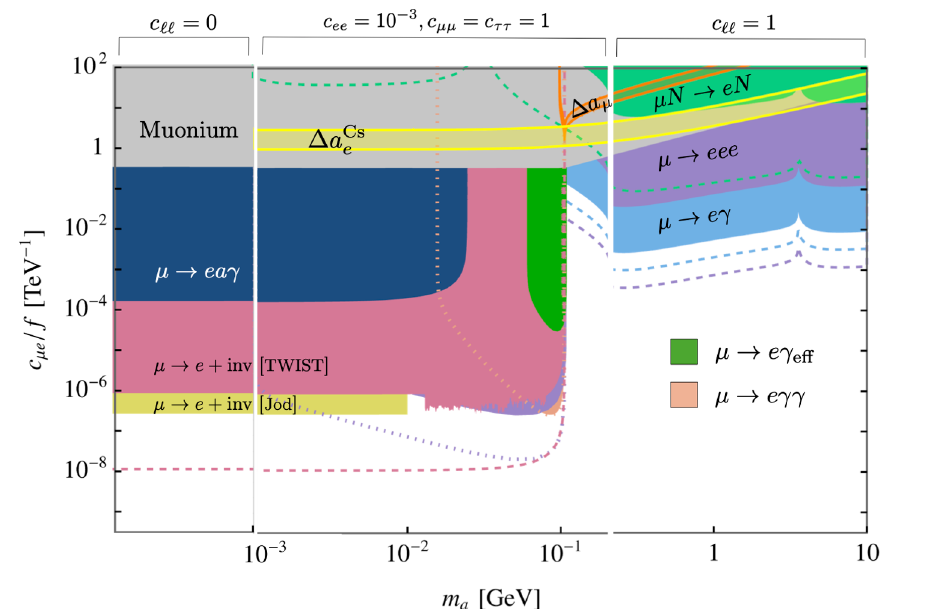
Figure 43 . Bounds on ALP mediated flavor off-diagonal transitions between muons and electrons p with c | [ k E ] 21 | 2 + | [ k e ] 21 | 2 , assuming universal ALP couplings to leptons as indicated above µe ≡ the plot for the different ALP mass regions. The bound by TWIST assumes that the ALP coupling to leptons is given by [ k ] + [ k ] E 21 e 21